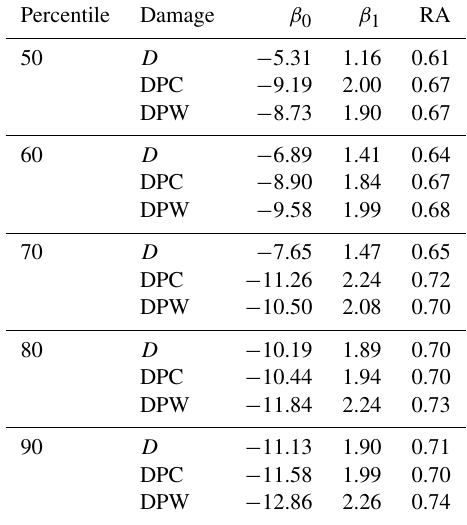
Figure 4. Example of logistic regression result used to model DPW damages above the 70th percentile as a function of precipitation (log-transformed precipitation given in millimetres). The solid line indicates the best estimate while the shaded band indicates the 95% confidence interval. Open circles along the horizontal axis show the events that are above (top) and below (bottom) the 70th percentile. Table 3. Parameters of the logistic model and RA values for the basin level with 60mm24h − 1 maximum precipitation threshold. All the results are significant ( p value < 0 . 01). Number of flood cases: 239.